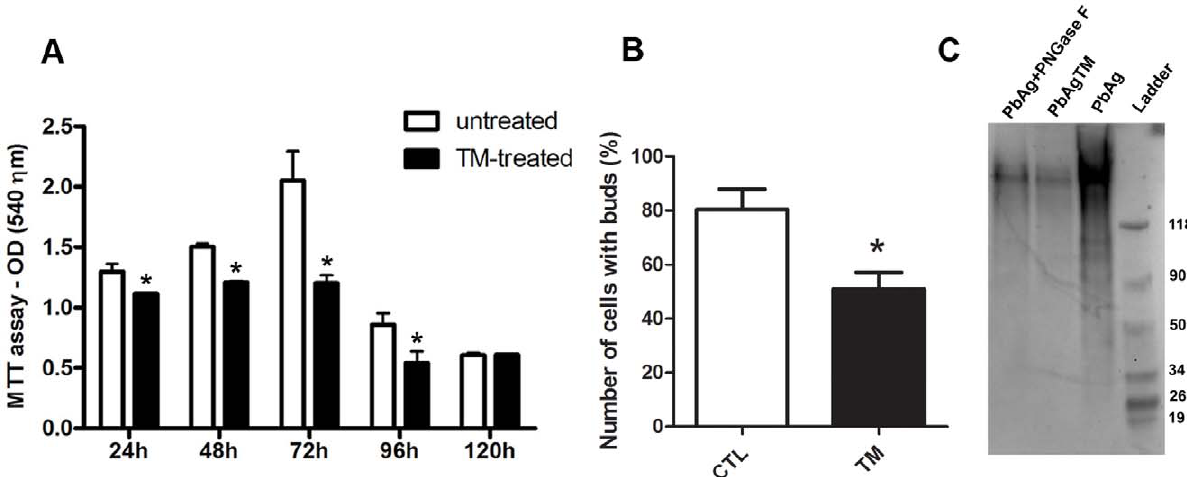
Figure 1. Effect of tunicamycin (TM) on the growth and budding of P.brasiliensis yeast cells. MTT assay of yeast cells cultivated in YPD medium in the absence (white bars) or presence (black bars) of 15 m g/mL TM (A). Number of cells with buds in YPD medium in the absence (white bar, CTL) or presence (black bar, TM) of 15 m g/mL TM for 72 h at 37 u C, and analyzed by optical microscopy and counted using neubauer chamber (B). Western blotting with ECL glycoprotein detection of the crude extract fully glycosylated (PbAg), crude extract underglycosylated (PbAgTM) and crude extract fully glycosylated treated with N-glycanase PNGase F (PbAg + PNGase F) (C). Data are representative of 3 independent assays. * p , 0.05 for comparison between CTL and TM.